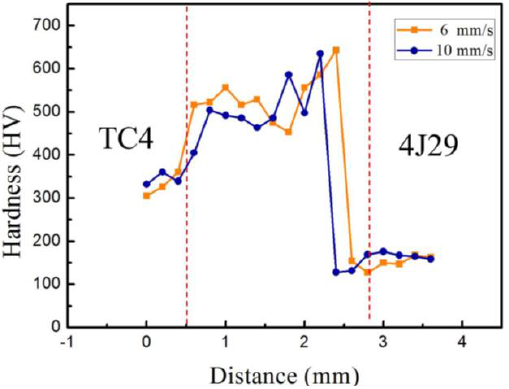
Figure 7. Micro-hardness distribution across the cross-sections of welded joints at different welding speeds.